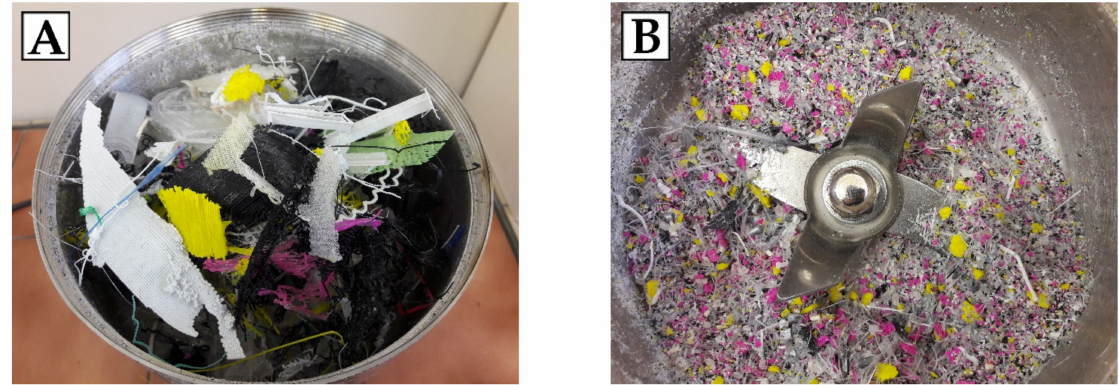
Figure 11. Appearance of PLA waste used for the synthesis of eco-polyol: ( A ) before grinding; ( B ) after grinding. A total of 50.0 g of ground PLA, 50.0 g of MEG and 0.01 g of ZC were put into the three-necked flask with a reflux condenser, a thermometer and a mechanical stirrer.